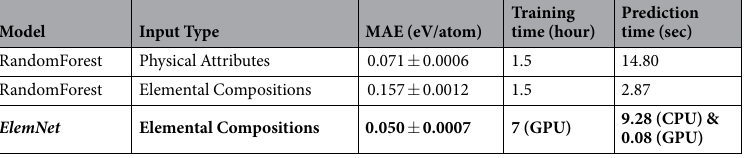
Table 1. Benchmarking our deep learning model– ElemNet –against conventional machine learning approaches. We trained several conventional ML models such as Linear Regression, SGDRegression, ElasticNet, AdaBoost, Ridge, RBFSVM, DecisionTree, ExtraTrees, Bagging and Random Forest. Out of them, Random Forest performed the best with and without using physical attributes. Here, we show the results from our deep learning model and the best conventional ML model- Random Forest, in our study for both types of model inputs (without and without physical attributes), along with the type of input used, mean absolute error (MAE) on the test set, training time on the training set, and prediction time on the entire test set (25,662 entries). All the models are trained and tested using a ten-fold cross validation. All timings are on a single (logical) CPU core of